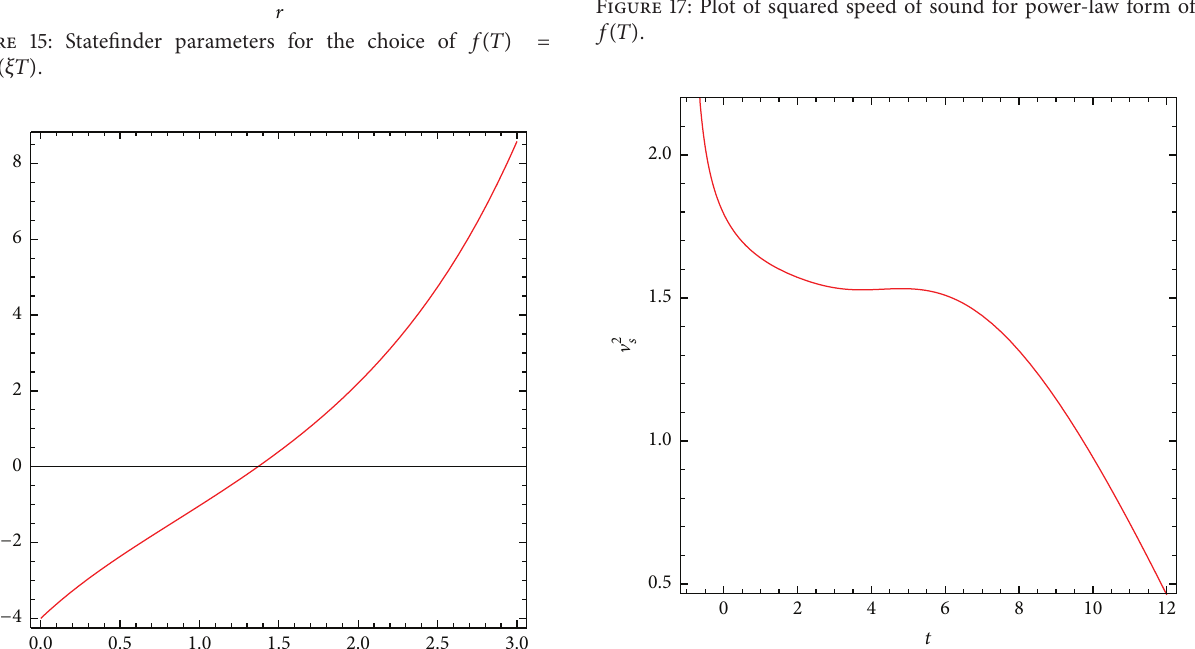
Figure 18: Plot of squared speed of sound for exponential form of 𝑓(𝑇)